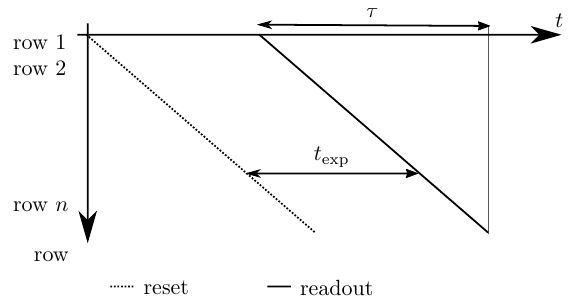
Figure 4: Rolling shutter readout scheme. The sensor is reset line by line at constant speed. One line is read simultaneously. After the exposure time t exp , the sensor starts the read-out line by line. At time t = 0 the first row of the sensor is reset. It is read out at time t = t exp . Consecutive lines are reset and read out one after the other. The sensor readout is finished after the rolling shutter readout time τ